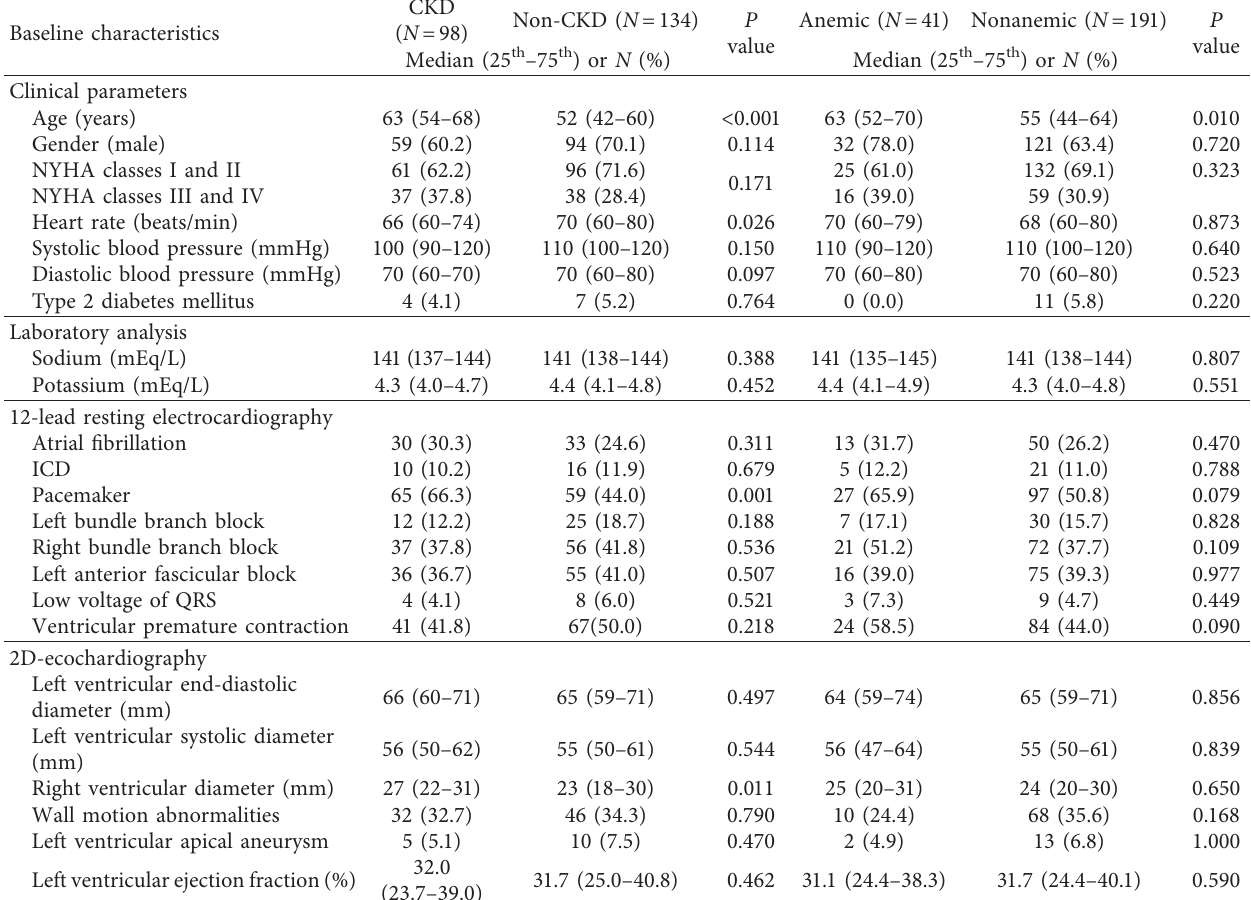
Table 2: Association between chronic kidney disease or anemia and other baseline characteristics.